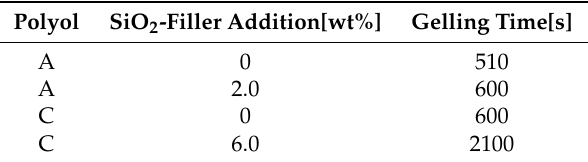
Table 3. Gelling time at 20 ◦ C for polyglycerol- and sucrose-based PUR adhesives (NCO / OH ratio 1.0). Polyol SiO 2 -Filler Addition[wt%] Gelling Time[s] A 0 510 A